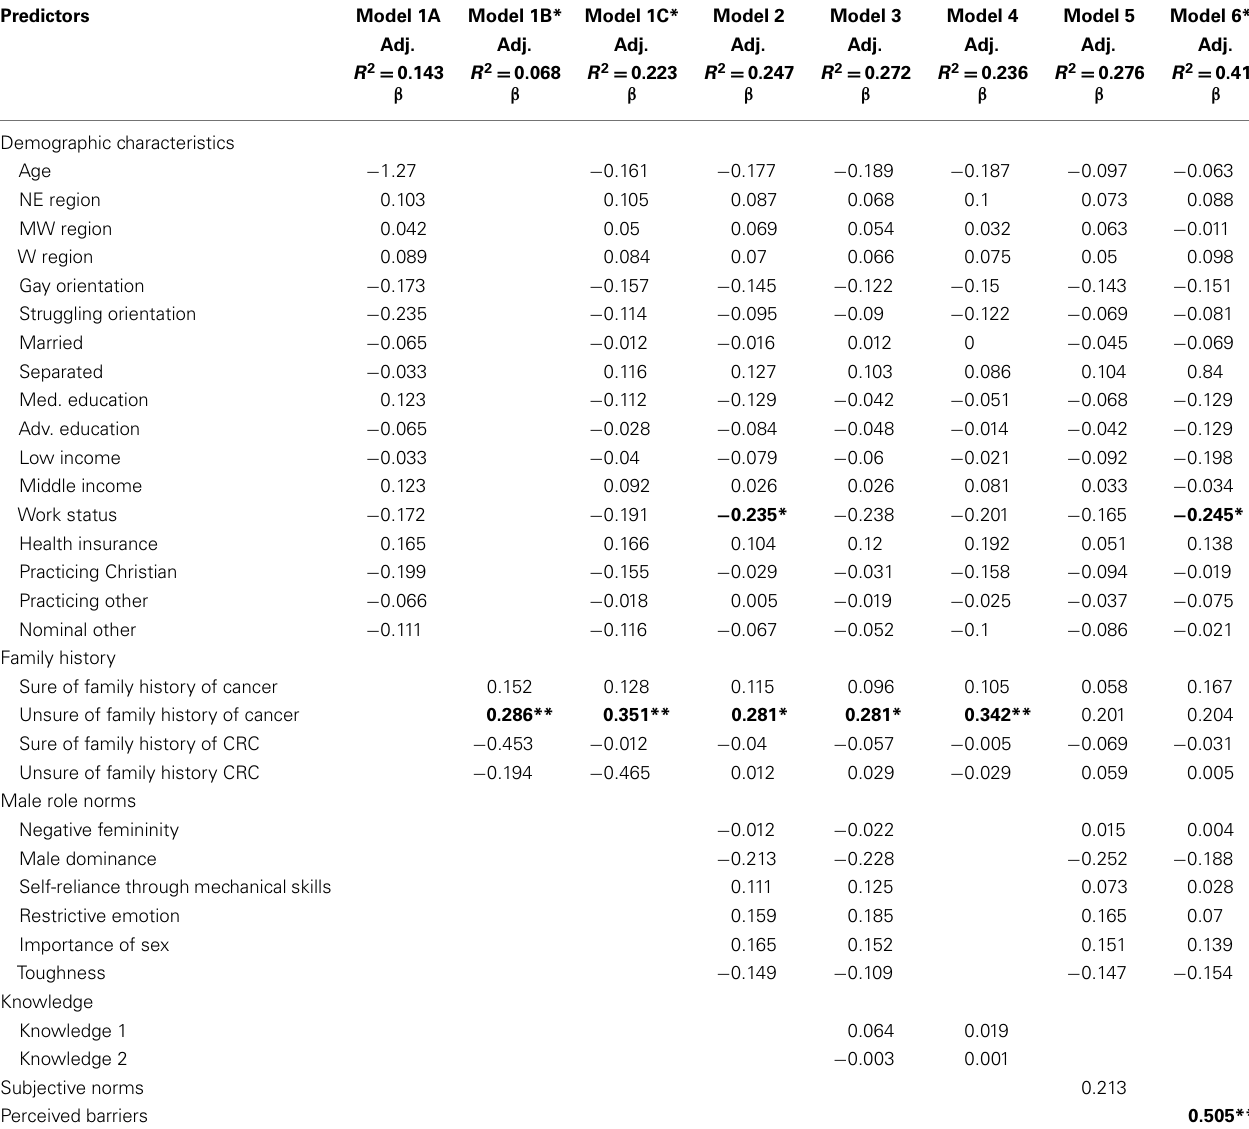
Table 3 | Standardized beta coefficients for predictors of attitudes toward colorectal cancer screening , according to regression models .